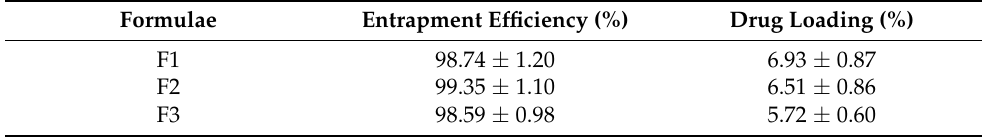
Table 2. The mean entrapment efficiency and drug loading of the